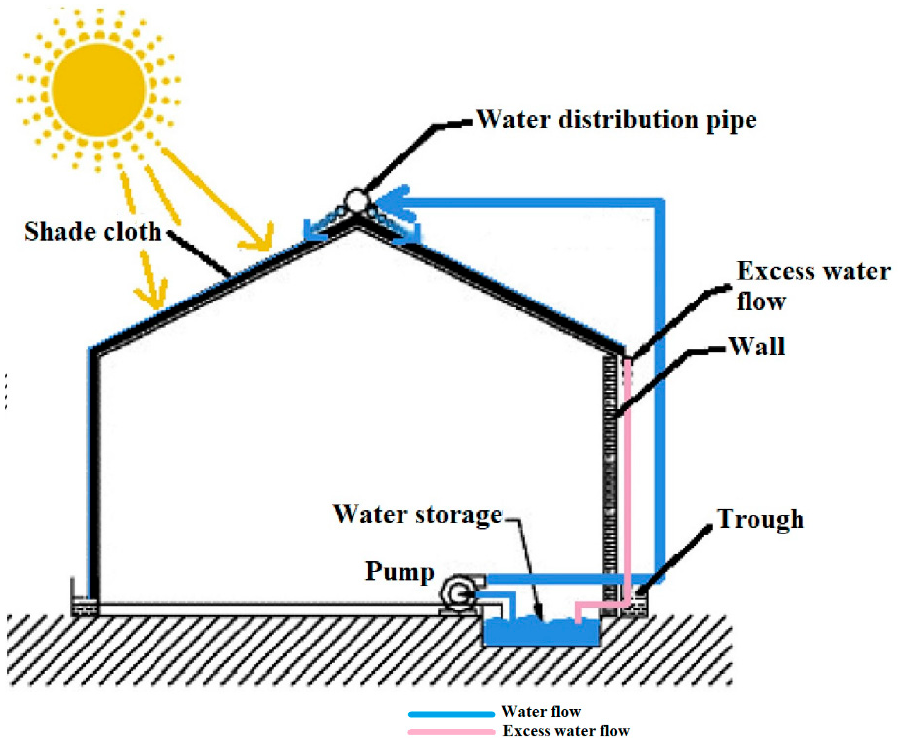
Figure 6. Schematic of cooling by roof evaporative system. Reprinted with permission from Ref. [97]. Copyright 2019